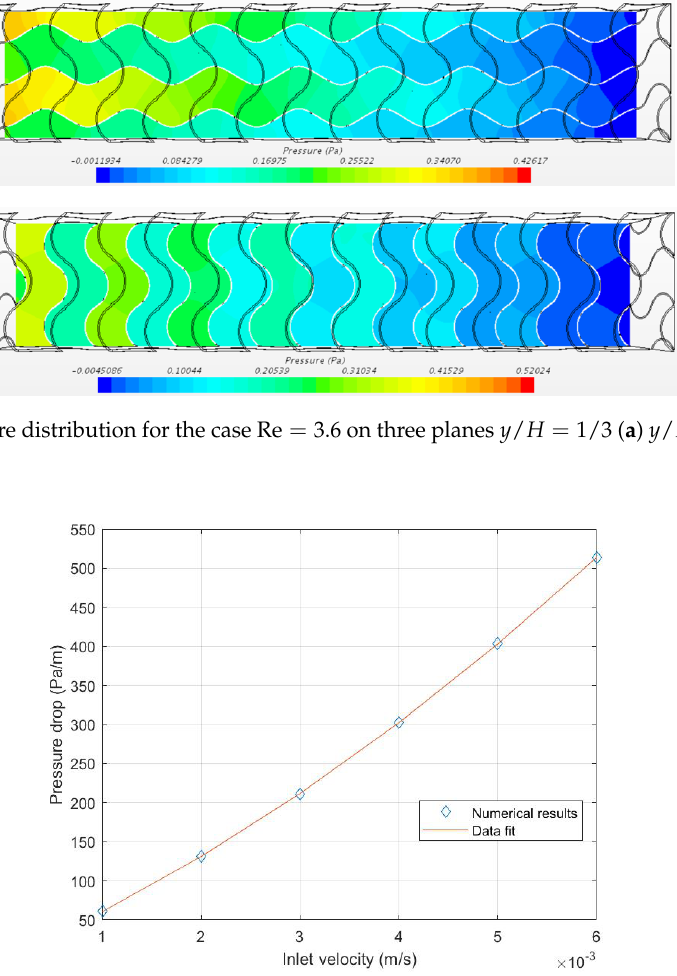
Figure 9. Pressure gradient versus inlet